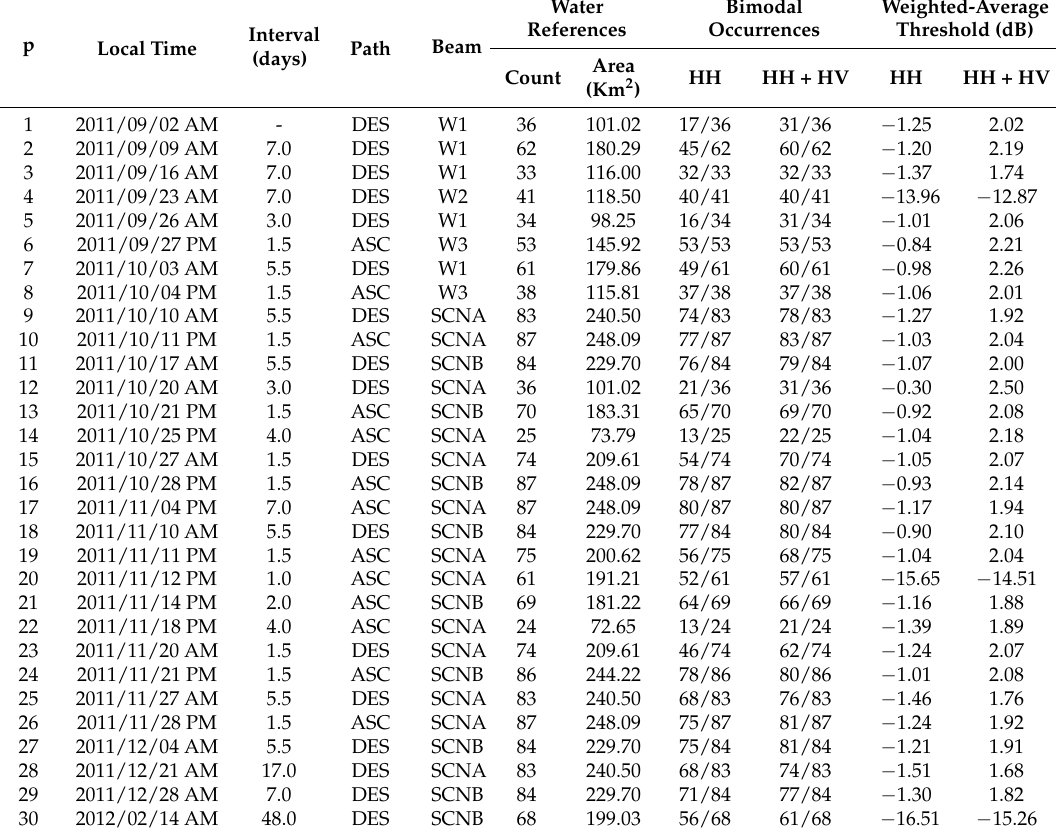
Table 2. List of RADARSAT-2 images and threshold values for water